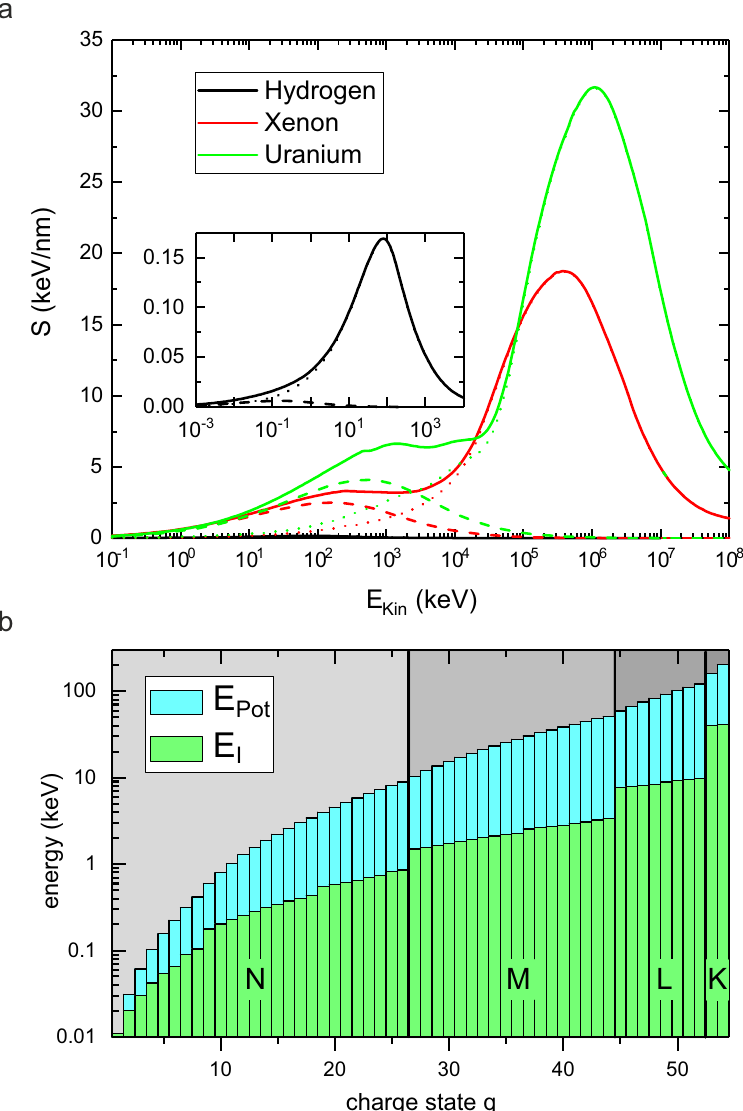
Figure 1. Energy deposition by swift heavy and highly charged ions. ( a ) Total stopping power S (continuous lines) of various ion species (H, Xe, U) in graphite as a function of the kinetic energy of the projectile calculated with SRIM. The contribution of nuclear stopping S n is plotted with dashed lines, of electronic stopping S e with dotted lines. The data for protons is shown in the inset. ( b ) Potential energy E pot of a Xe ion as a function of its charge state q (blue bars). The green bars depict the ionization energy E I of the last electron. Jumps in the ionization energy occur after an electron shell has been completely